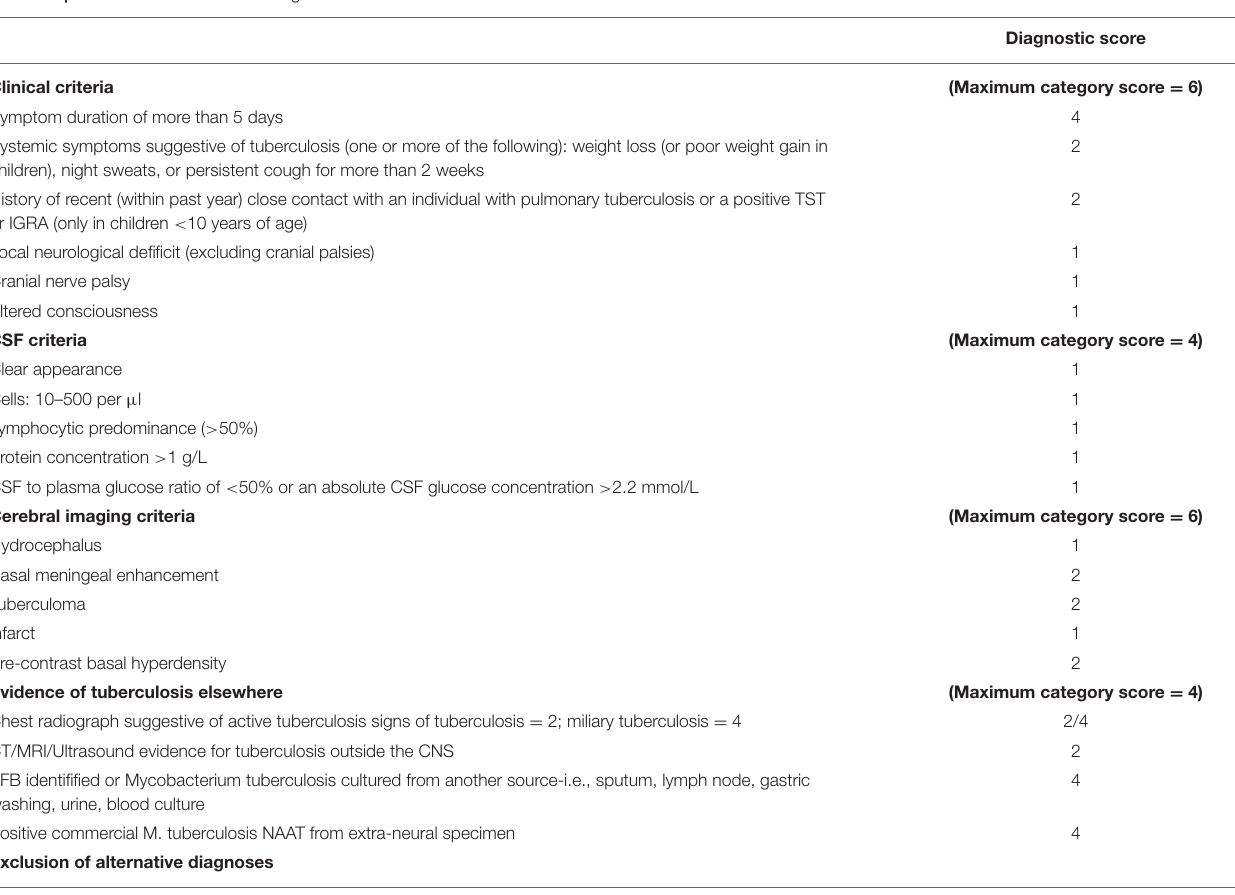
TABLE 2 | The Marais criteria for the diagnosis of TBM on